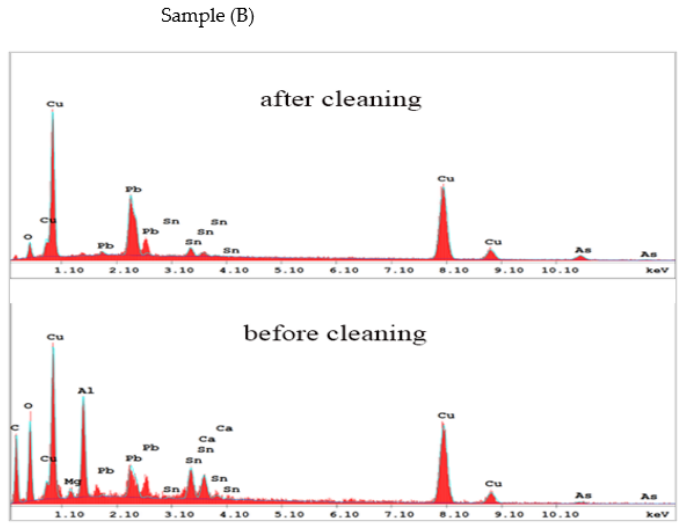
Figure 14. The EDX analysis of the coin (B) before and after laser cleaning.